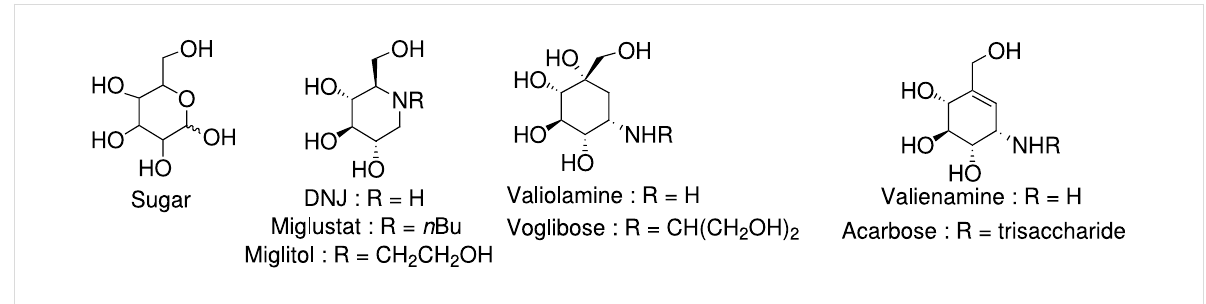
Figure 1: Sugars, iminosugars and carbasugars.